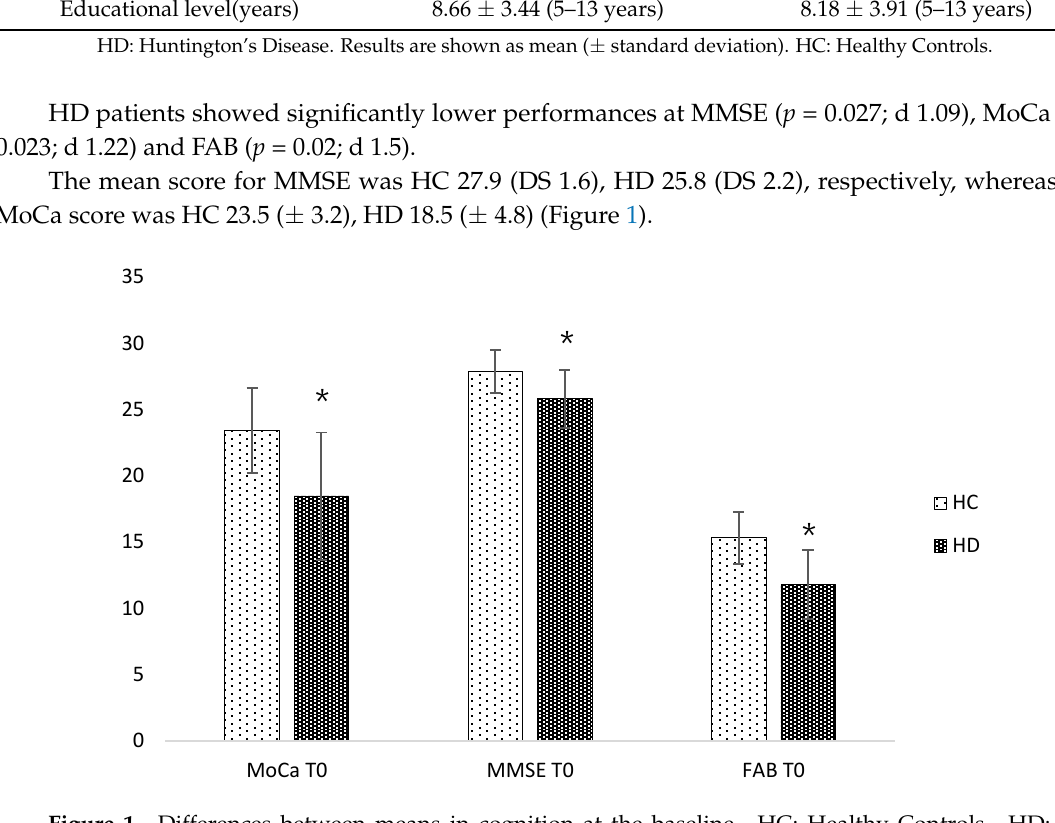
Figure 1. Differences between means in cognition at the baseline. HC: Healthy Controls. HD: Huntington’s Disease. MoCa: Montreal Cognitive Assessment; MMSE: Mini Mental State Examination; FAB: Frontal Assessment Battery. * p < 0.05. Error Bar ± 1 standard deviation.